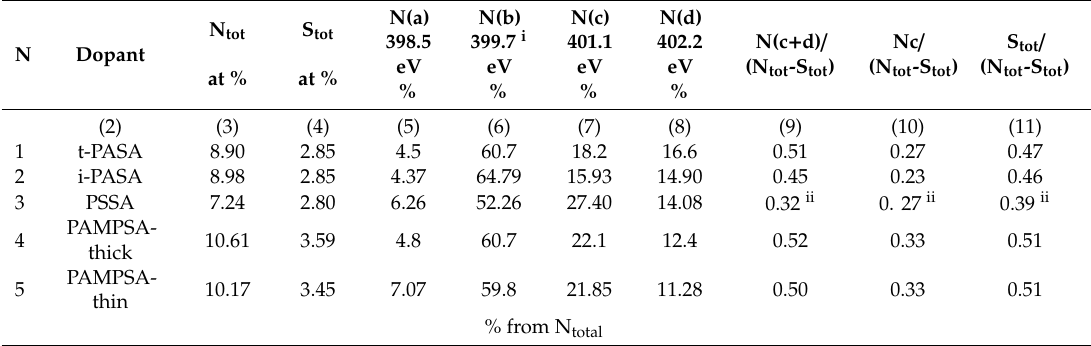
Table 3. Data for the atomic content of nitrogen and sulfur and relative rations of N obtained from XPS studies and for the electrochemical redox number.